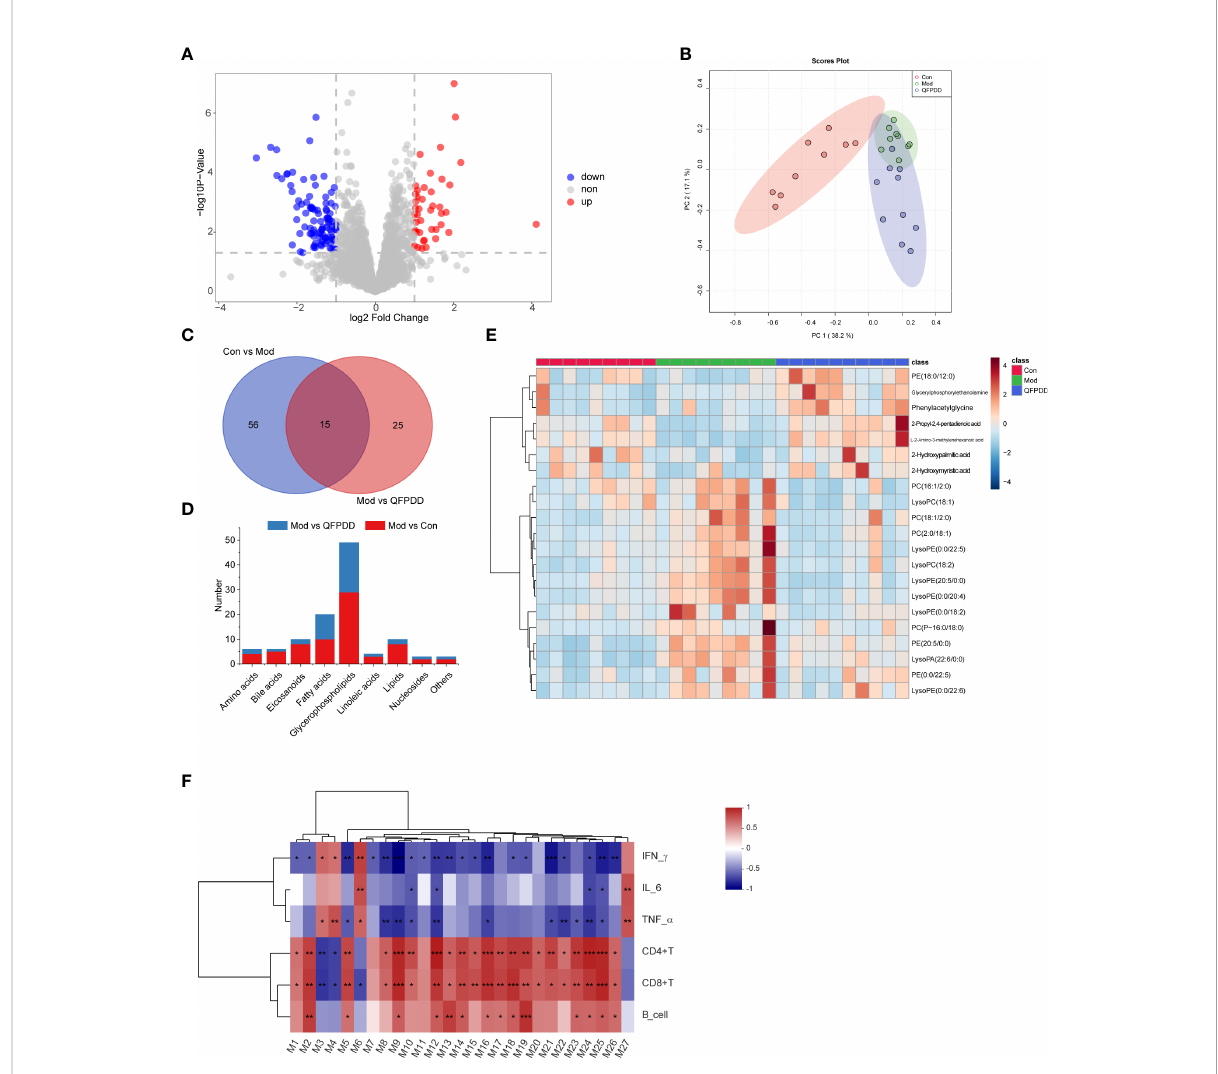
FIGURE 4 Metabolome analysis of the serum. (A) Volcano plot showing changes in DMs in the Mod and QFPDD groups. (B) The principal component analysis (PCA) plots established based on DMs in the Con, Mod, and QFPDD groups. (C) Venn diagram of DMs in the Con, Mod, and QFPDD groups. (D) The categories and number of DMs obtained from the Con, Mod, and QFPDD groups. (E) Heatmap diagram of DMs in the Con, Mod, and QFPDD groups. (F) Serum differential metabolites signi fi cantly correlated with immune and in fl ammatory indicators. Signi fi cance levels are indicated as follows: *, p < 0.05; **, p < 0.01, ***, p <